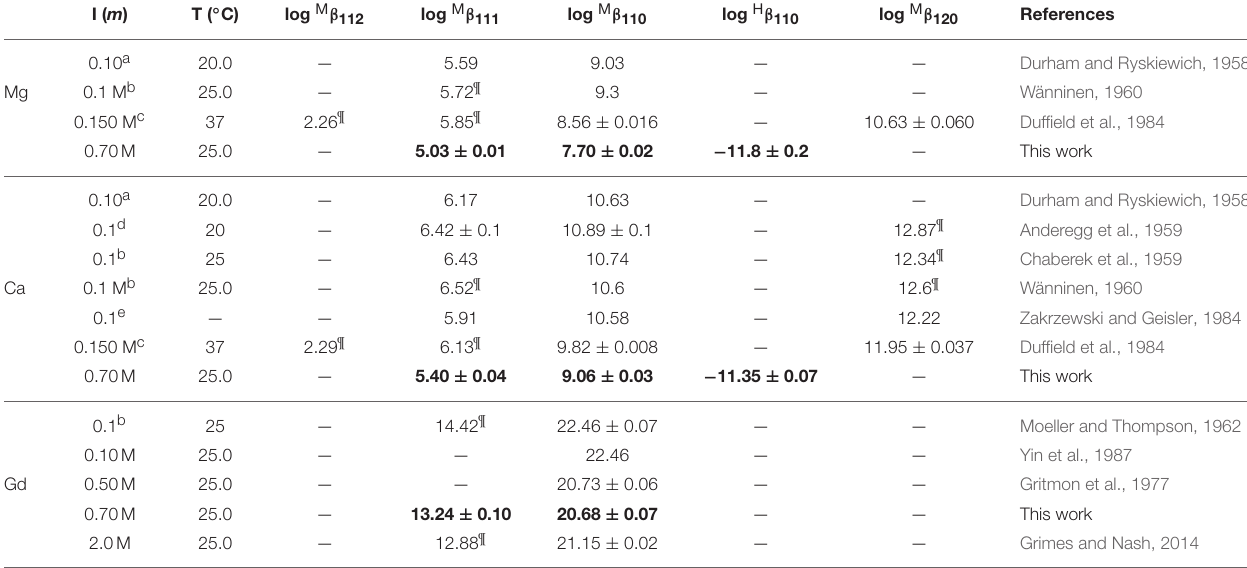
Results from the present work are shown in bold type. ¶ Calculated from stepwise stability constants or from acid dissociation constants of the metal complex. a